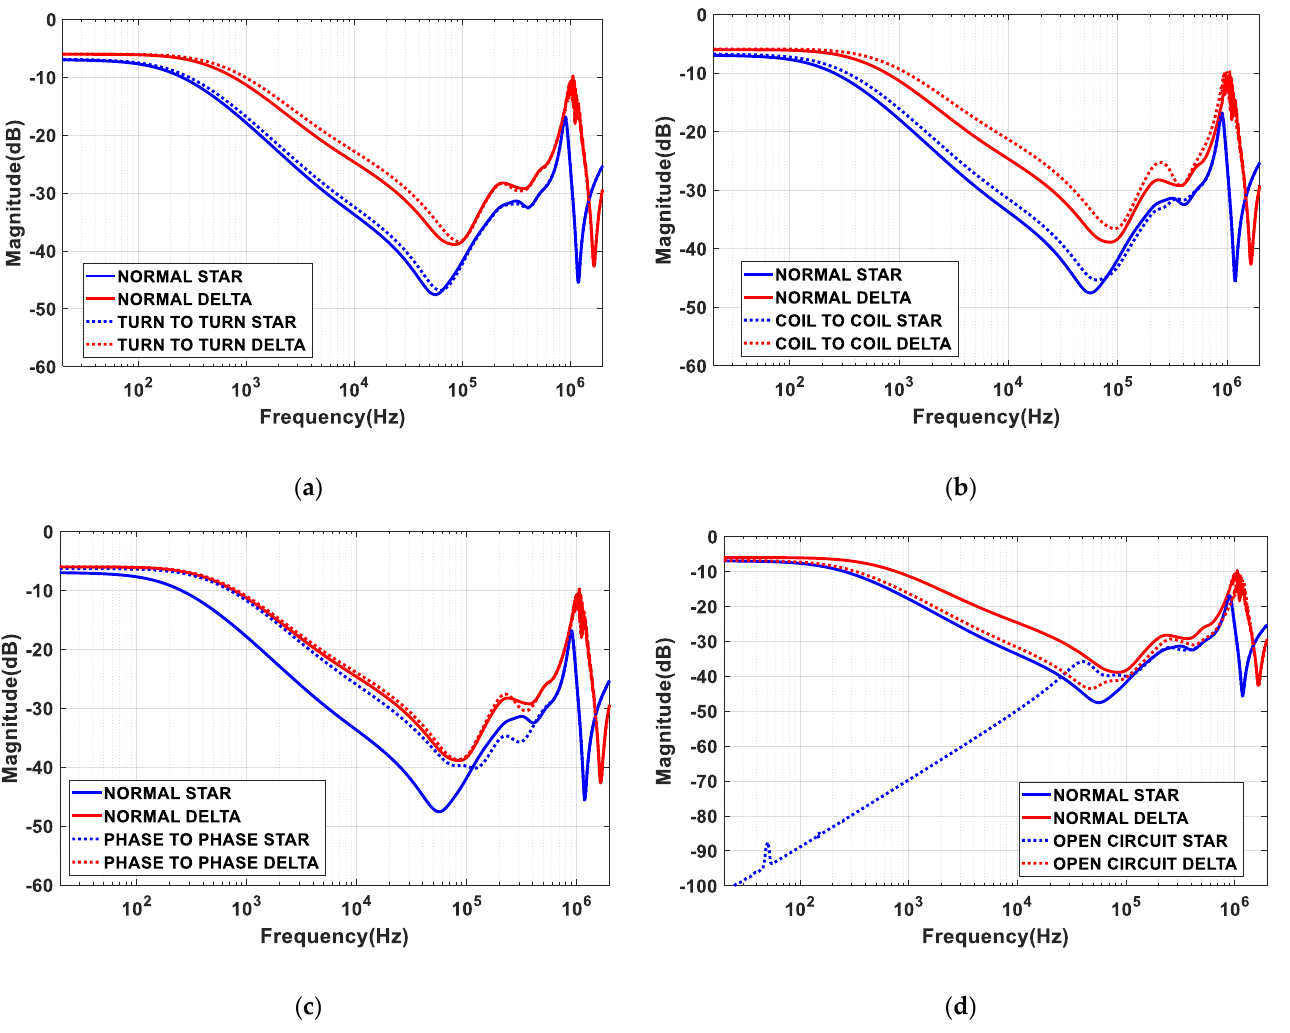
Figure 3. FRA measured responses for star vs. delta of 1 HP IM at ( a ) Normal vs. Turn-to-Turn, ( b ) Normal vs. Coil-to-Coil, ( c ) Normal vs. Phase-to-Phase SC fault and ( d ) Normal vs. open circuits.